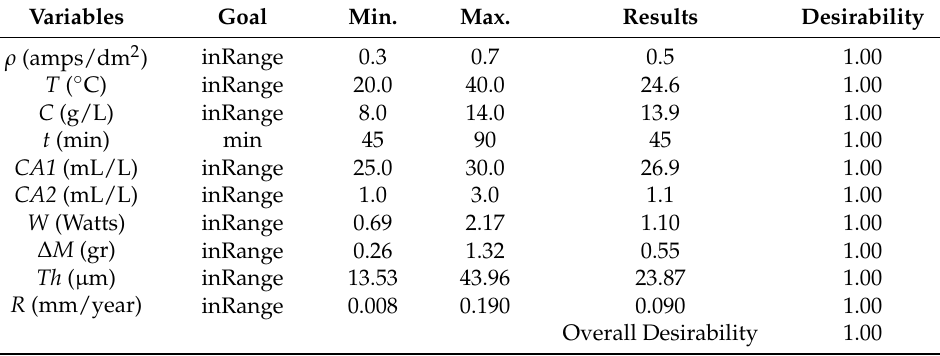
Table 11. The second criterion that was considered: minimizing the coating deposition time ( t ). Variables Min.